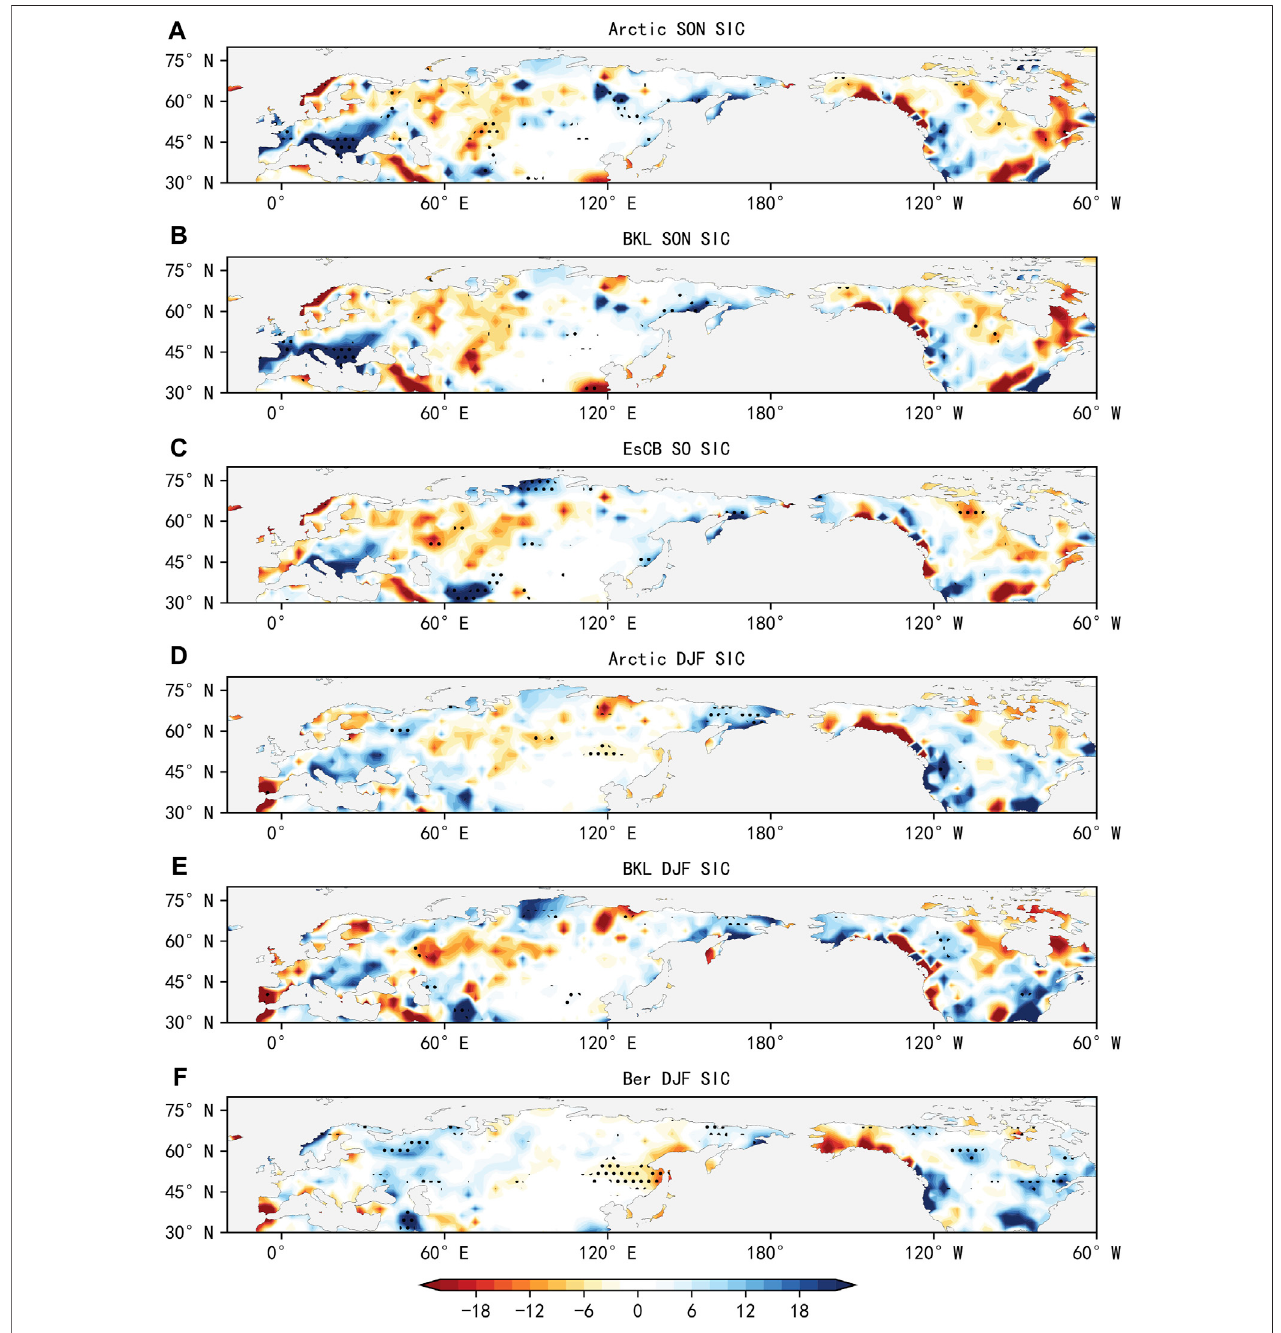
FIGURE 8 | As in Figure 6 but for the interdecadal component of precipitation.